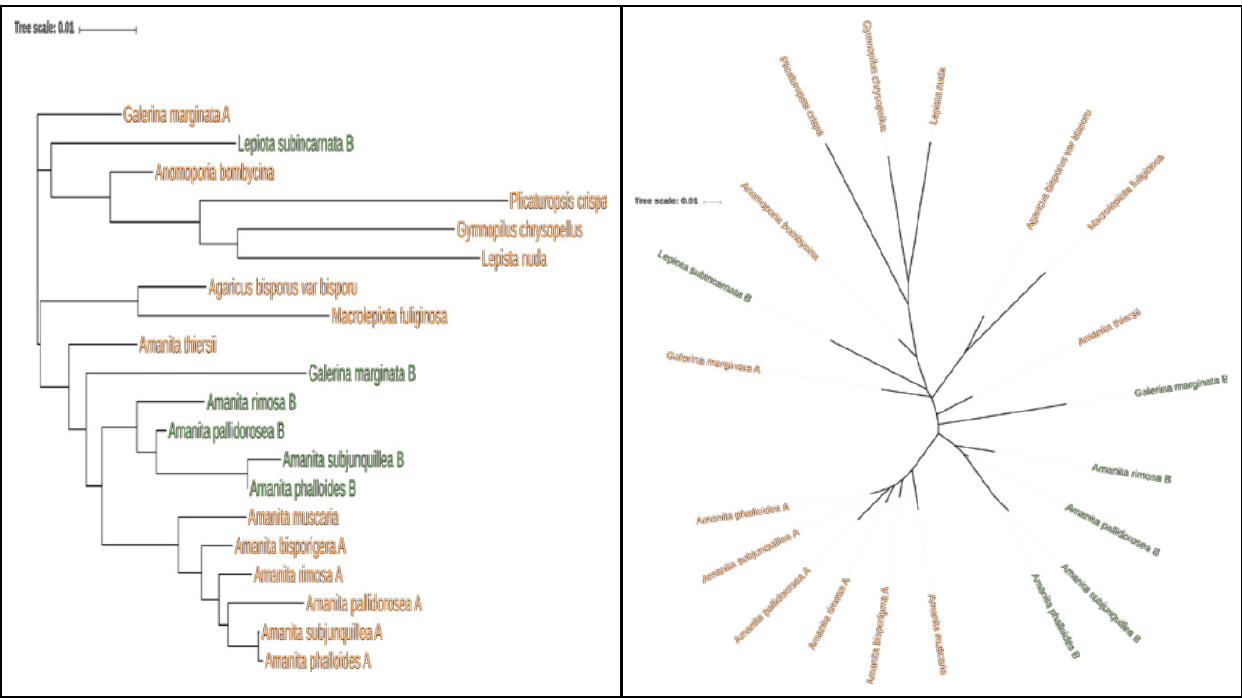
Fig. 8. ?(cid:13)(cid:8)(cid:10)(cid:9)(cid:17)(cid:5)(cid:19)(cid:23)(cid:13)(cid:4)(cid:8)(cid:11)(cid:21)(cid:13)(cid:2)(cid:26)(cid:10)(cid:13)}(cid:5)(cid:13)(cid:17)(cid:19)(cid:22)(cid:2)(cid:9)(cid:17)(cid:9)(cid:23)(cid:22)(cid:7)(cid:11)(cid:7)(cid:2)(cid:4)(cid:26)(cid:2)(cid:8)(cid:14)(cid:13)(cid:2)(cid:135)q(cid:135)(cid:2)(cid:7)(cid:13)}(cid:5)(cid:13)(cid:17)(cid:19)(cid:13)(cid:7)(cid:2)(cid:5)(cid:7)(cid:13)(cid:21)(cid:2)(cid:11)(cid:17)(cid:2){(cid:11)(cid:25)(cid:28)(cid:2)=$(cid:28)(cid:2)?(cid:10)(cid:13)(cid:13)(cid:2)(cid:25)(cid:11)’(cid:13)(cid:17)(cid:2)(cid:9)(cid:7)(cid:2)(cid:10)(cid:4)(cid:4)(cid:8)(cid:13)(cid:21)(cid:2)(cid:24)(cid:23)(cid:13)(cid:26)(cid:8)(cid:27)(cid:2)(cid:9)(cid:17)(cid:21)(cid:2)(cid:5)(cid:17)(cid:10)(cid:4)(cid:4)(cid:8)(cid:13)(cid:21)(cid:2)(cid:24)(cid:10)(cid:11)(cid:25)(cid:14)(cid:8)(cid:27)(cid:28)(cid:2) Galerina POPB is placed within Amanita POPs, while Lepiota